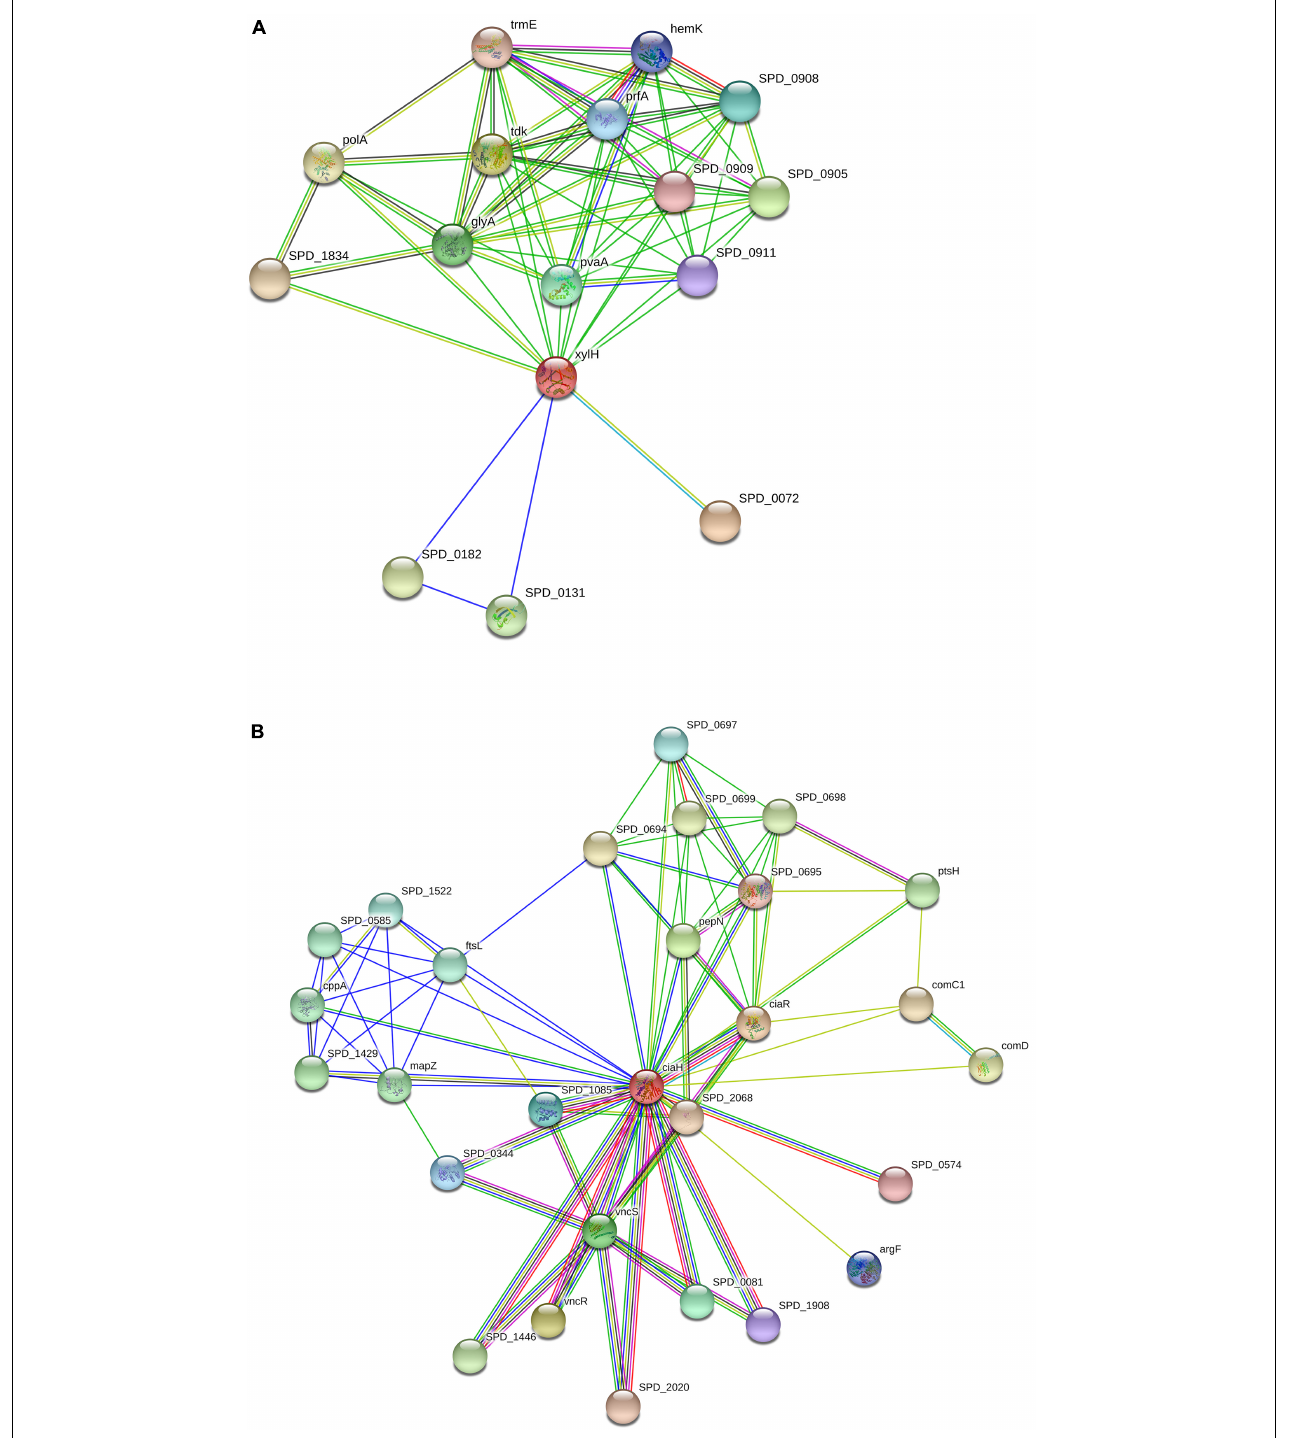
FIGURE 5 | Protein-protein interactions: Schematic PPI network generated through the STRING database for XylH (A) and CiaH (B) .